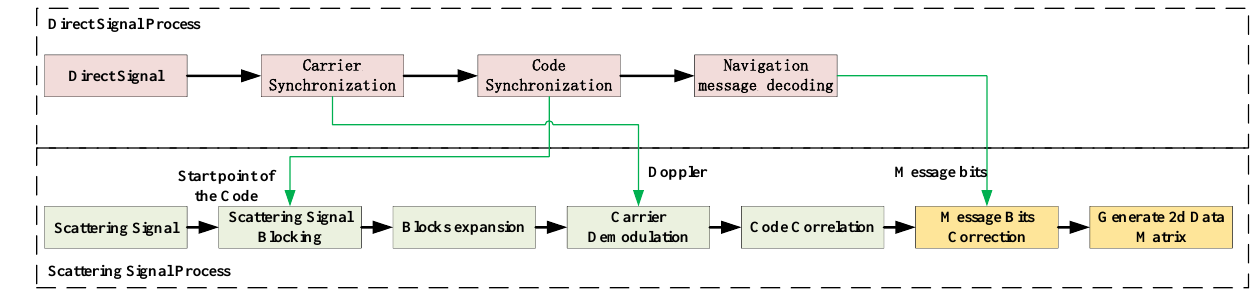
Figure 4. BEC algorithm flow chart.